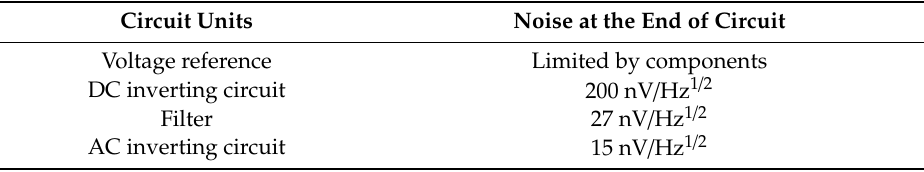
Table 3. The noise of the circuit units for carrier wave production. DC—direct current.